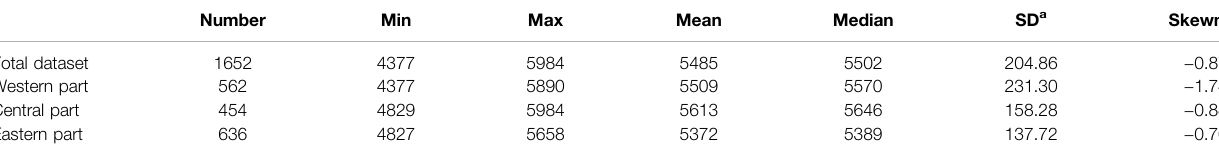
TABLE 1 | Statistics of the CFAs (m asl) of the Gangdise Mountains.